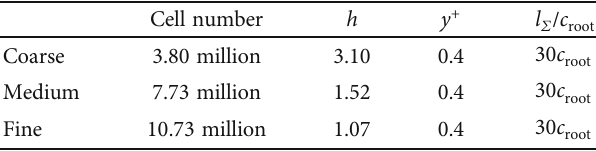
Figure 9: De fi nition of mesh domain used in CFD calculations. Table 1: Grid re fi nement study setup.